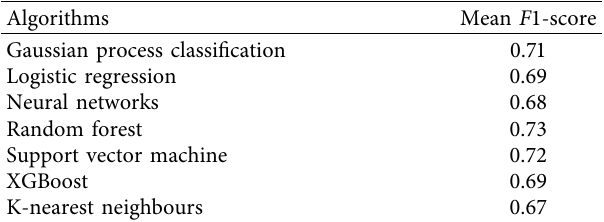
Table 2: Summary of mean F 1-score for text